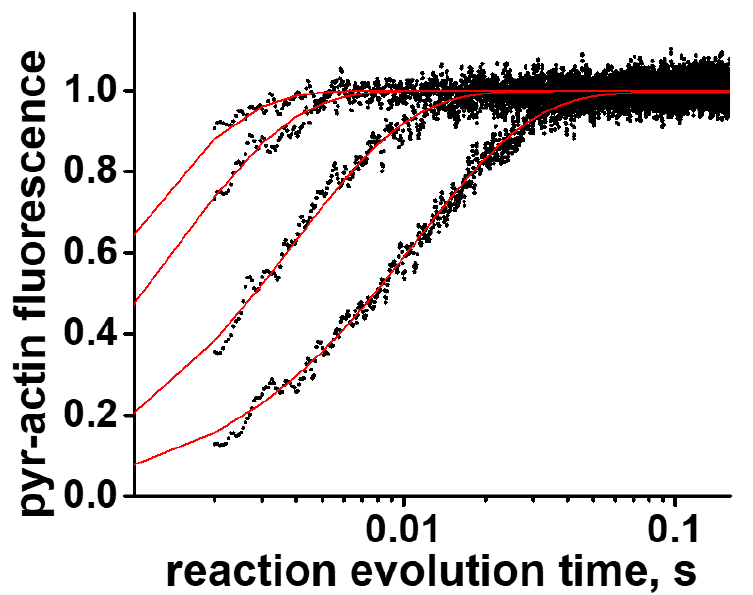
Figure 5. Example of fitted transients of ATP-induced actomyosin dissociation (reaction scheme Figure 2) to the numerical solution of the system of differential equations (Supplementary Equation (S1)). Transients, obtained for the same actomyosin preparation at different concentrations of ATP are fitted globally. The fitted parameters are k +1T , k − 1T , k +2T , k − 2T . Black dots, experimental data. Red lines, global fit. Actomyosin concentration is 1 µM, ATP concentrations are 30 µM, 90 µM, 300 µM, 600 µM.